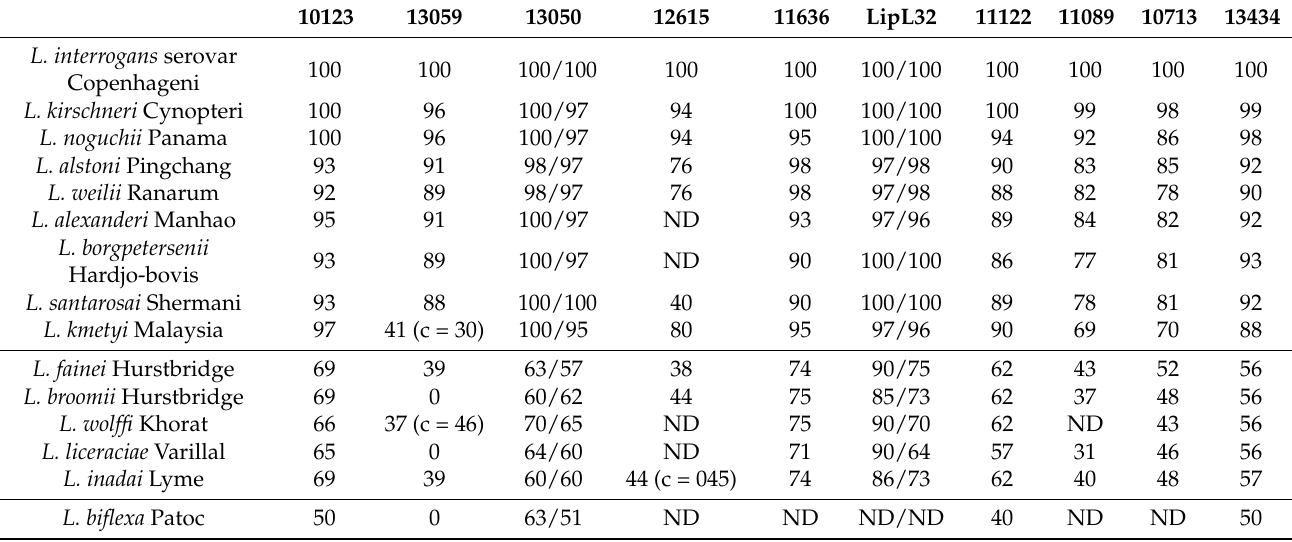
Table 2. rChi2 portion conservation among pathogenic, intermediate, and saprophyte